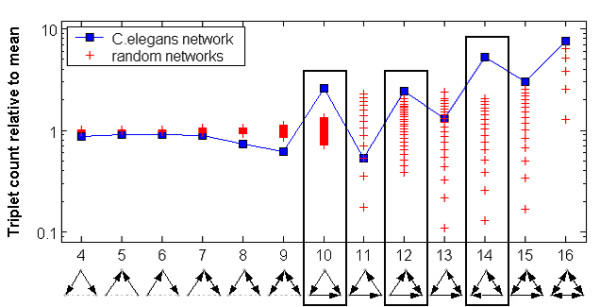
Triplet counts in the C. elegans network compared to the random matrix ensemble. Blue squares show triplet counts for the actual network (dataset 1, threshold Θ = 2), red crosses show counts for each random connectivity matrix relative to the mean count for the whole random matrix ensemble. Three framed motifs are discussed in the main text. All matrices in this ensemble (n = 1000) preserve the counts of uni- and bi-directional connections for each neuron. A count for a given pattern is often the same in many matrices resulting in few crosses (e.g. there are only 25 crosses for pattern 12 because the count of this pattern in the random matrix ensemble varies between 6 and 32; 29 and 31 were not observed).